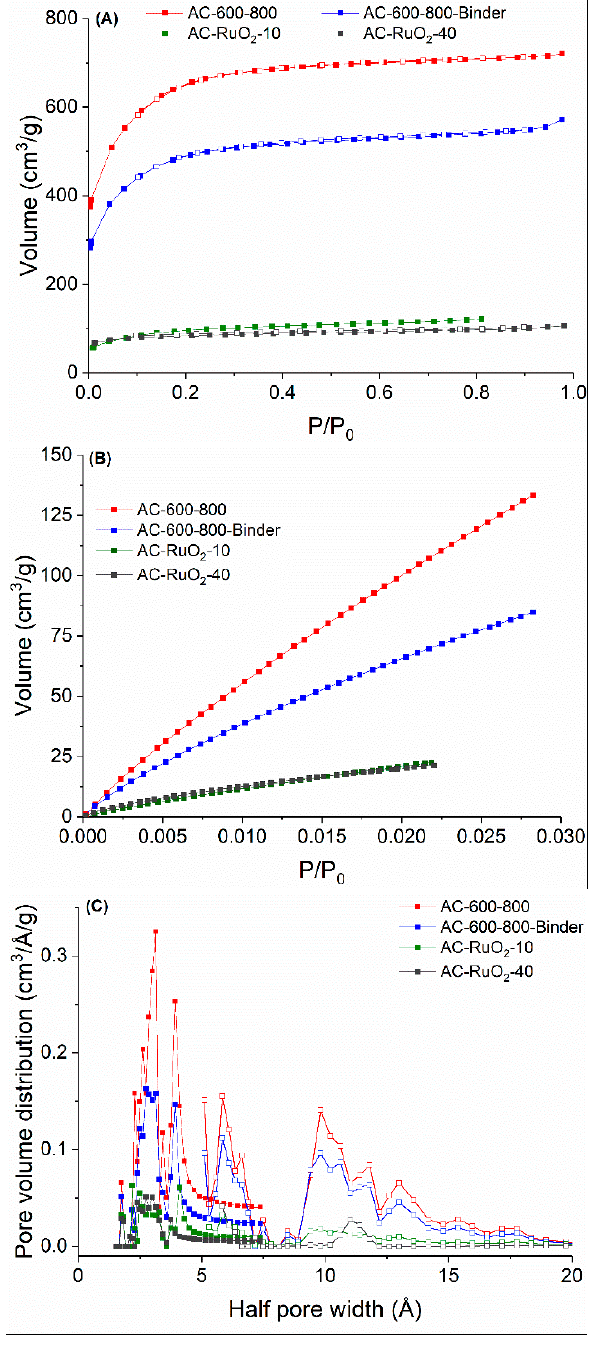
Figure 1. ( A ) N 2 adsorption (closed symbol) and desorption (open symbols) isotherms; ( B ) CO 2 adsorption isotherms; ( C ) pore size distribution calculated from the CO 2 (closed symbols) and N 2 (open symbols) isotherms.